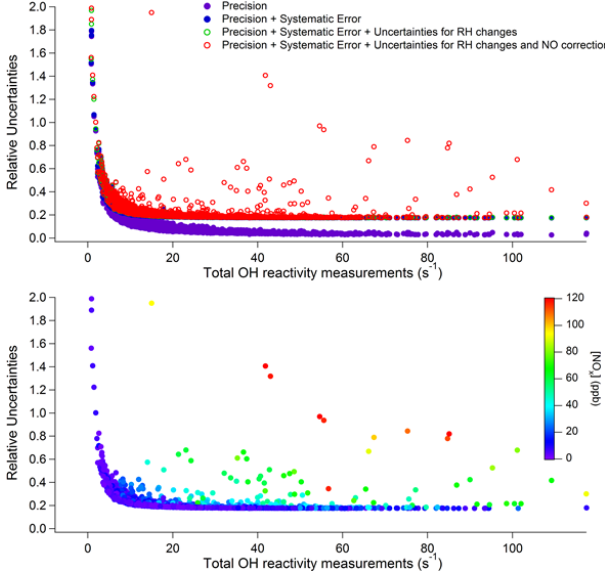
Figure 10. Total OH reactivity measurement uncertainties calcu- lated for the Dunkirk field campaign. Top panel: precision and rela- tive uncertainty as a function of total OH reactivity. Different levels of uncertainty are considered: (1) the precision observed when mea- suring the pyrrole signal (purple dots); (2) previous + systematic errors (see text), except for the humidity and NO corrections (blue dots); (3) previous + the humidity correction (green open dots); and (4) previous + the NO correction (red open dots). Bottom panel: to- tal uncertainty calculated in (4) as a function of total OH reactivity. These data have been color-coded as a function of NO x